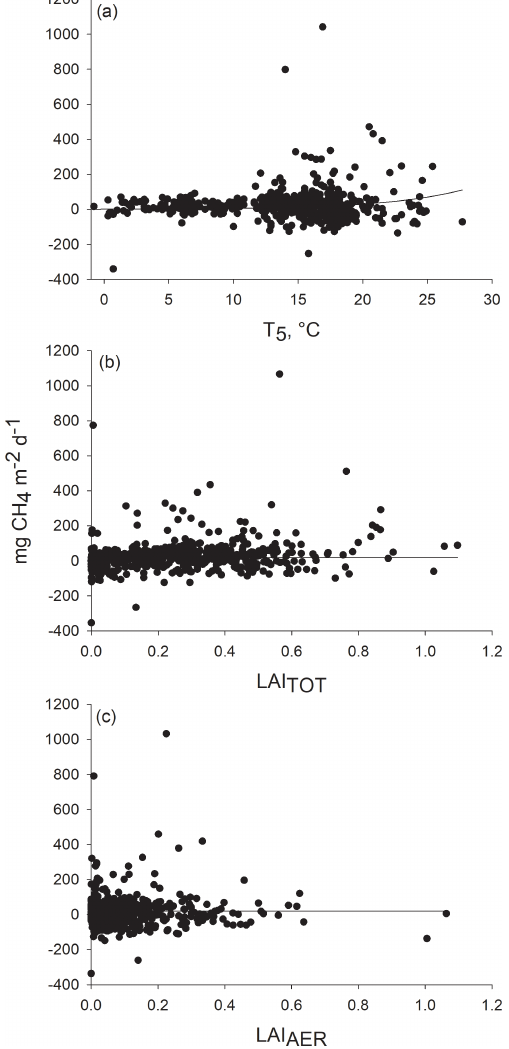
Figure 4. Response of methane flux to (a) peat temperature at the depth of 5cm, (b) total leaf area (LAI TOT ) and (c) leaf area of aerenchymatous plant species (LAI AER ) . Methane fluxes mea- sured in 2012–2014 were adjusted to (a) mean LAI TOT (0.2661) and LAI AER (0.1016), (b) mean peat temperature at the depth of 5cm (14 ◦ C) and mean LAI AER (0.1016), and (c) mean peat tem- perature at the depth of 5cm (14 ◦ C) and mean LAI TOT